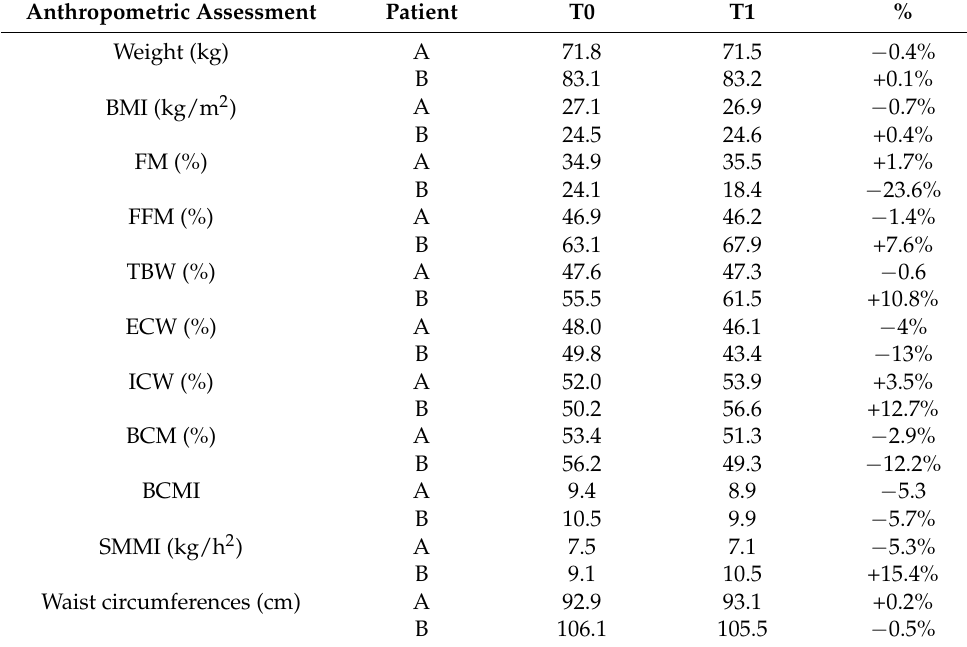
Table 3. Patient A and B anthropometric assessment before (T0) and after (T1) interventions. The comparisons between pre- and post-intervention data are expressed by the percentage variation (%). Anthropometric Assessment